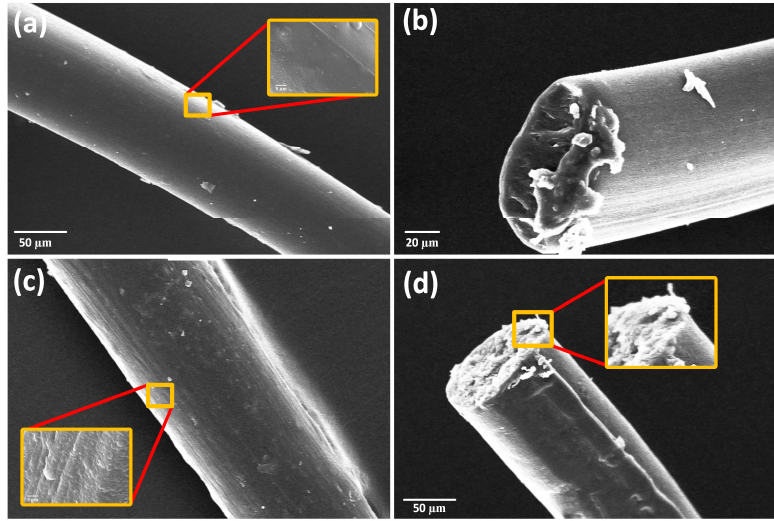
Figure 6. SEM images of PU and PU/RSF composite fibres: ( a ) longitudinal view of PU fibres; ( b ) fractured section of PU fibres; ( c ) longitudinal view PU/RSF (75/25) composite fibres; and ( d ) fractured section view PU/RSF (75/25) composite fibres.